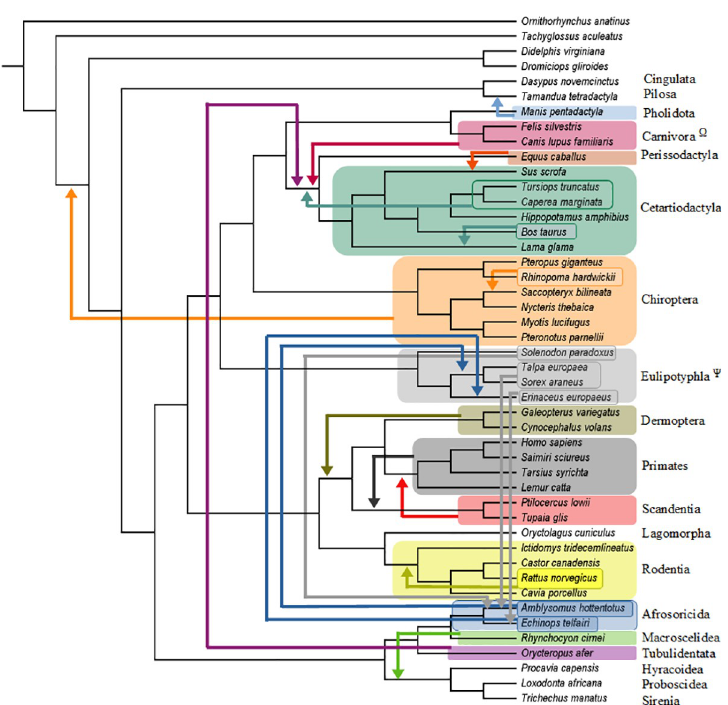
Fig 4. Summary of molecular scaffold analyses. Summary of the pseudoextinction results for the O’Leary et al. [31] data set for one of our seven sets of analyses (molecular scaffold only). Orders that were recovered in phylogenetic positions that conflict with the molecular scaffold are indicated by arrows. Any shifts of individual species are also indicated by arrows. All analyses recovered a single most parsimonious tree (MPT). Only seven orders (37%) (Proboscidea, Sirenia, Lagomorpha, Hyracoidea, Cingulata, Pilosa, Rodentia) remained in the correct interordinal position when pseudoextinct. C = MPT supports Chiroptera as sister to (Perissodacyla + Cetartiodactyla), O = MPT supports Chiroptera as sister to